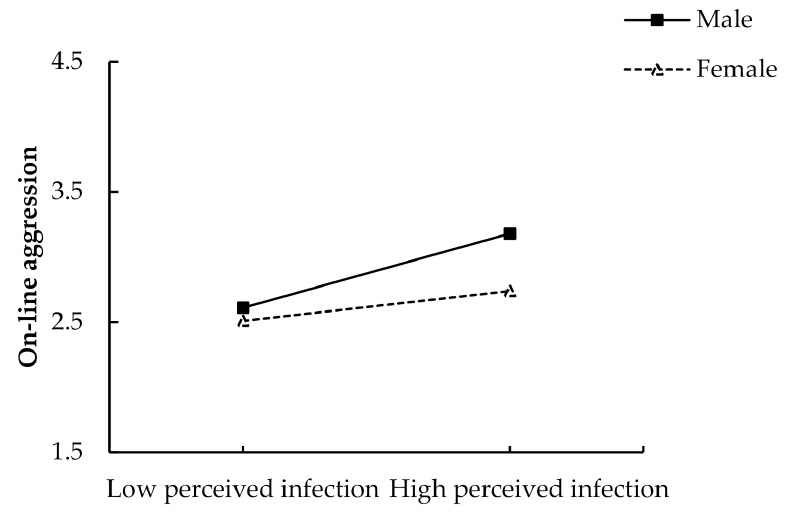
Figure 4. Gender as a moderator for the relationship between perceived infection and online-aggression. However, the interactions between perceived infection and gender were not significant for anxiety ( β = 0.17, SE = 0.13, t = 1.33, p = 0.18), depression ( β = 0.06, SE = 0.15, t = 0.39, p = 0.69), and depressive disorder ( β = − 0.14, SE = 0.24, t = − 0.59, p =